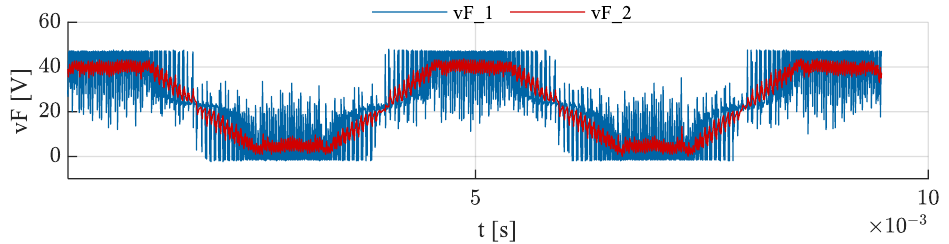
Figure 12. Oscilloscopic record of the measured voltage during the steady-state three-phase operation.